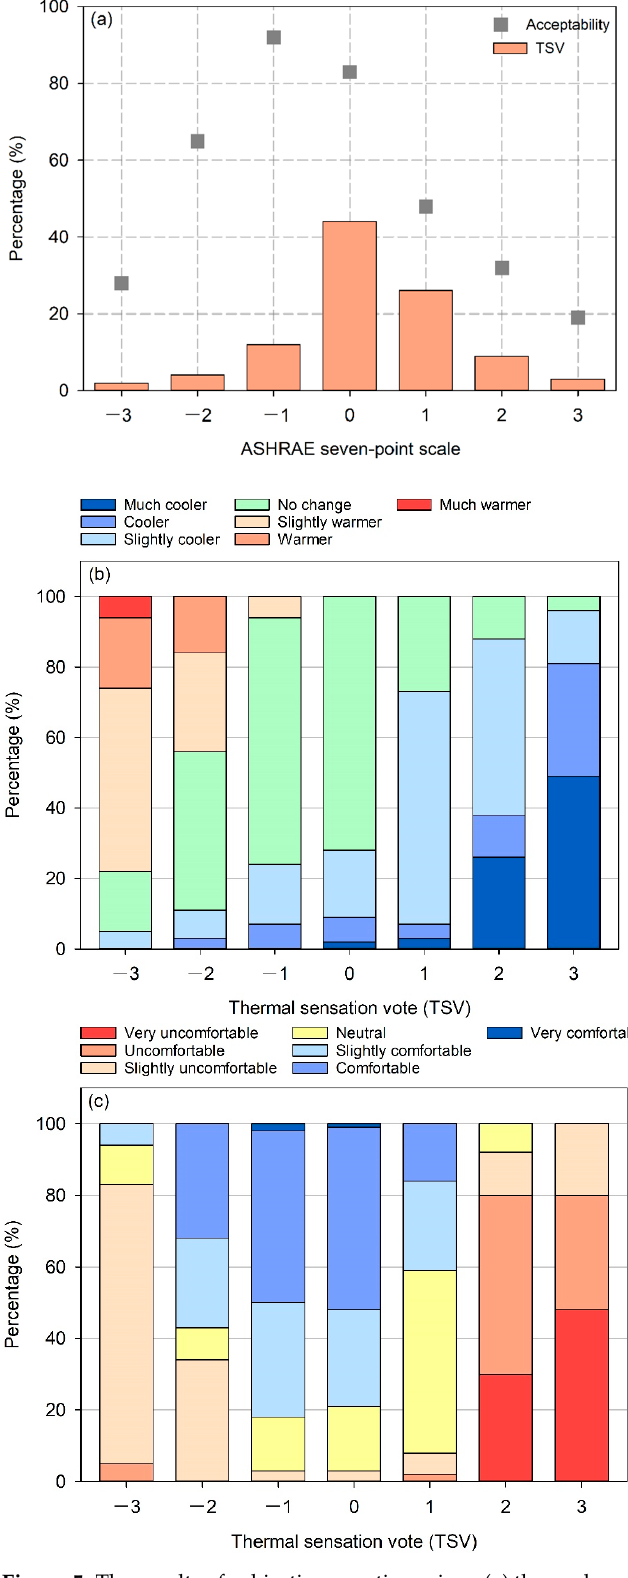
Figure 5. The results of subjective questionnaires: ( a ) thermal sensation vote and thermal acceptability; ( b ) distribution of thermal expectative vote in each TSV interval; ( c ) distribution of overall comfort vote in each TSV interval.